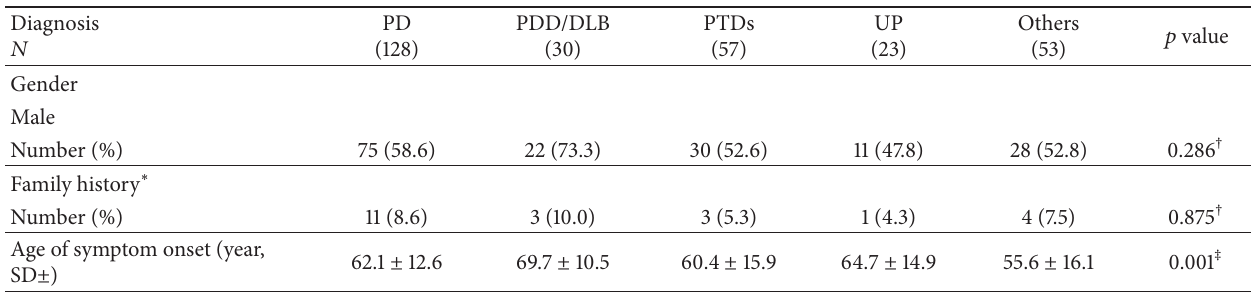
Table 1: Baseline characteristics.